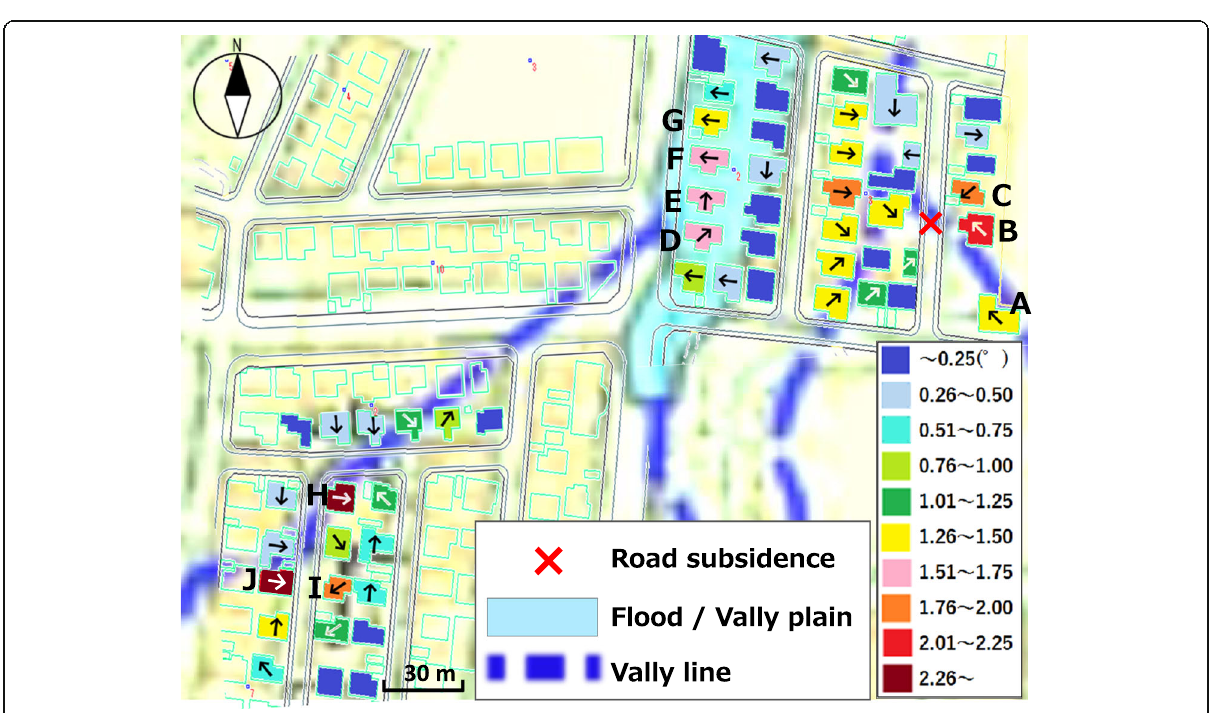
Fig. 9 Superposition of outer wall slope and former terrain